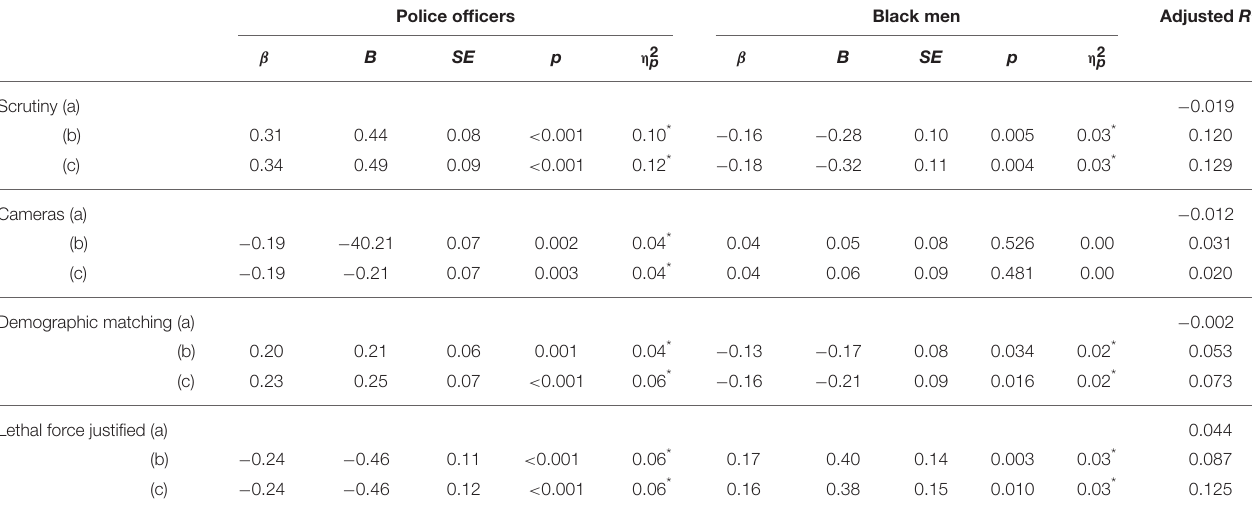
TABLE 3 | Results of Study 1b regression analysis using threat associated with police officers and Black men to predict support for policing policy reform